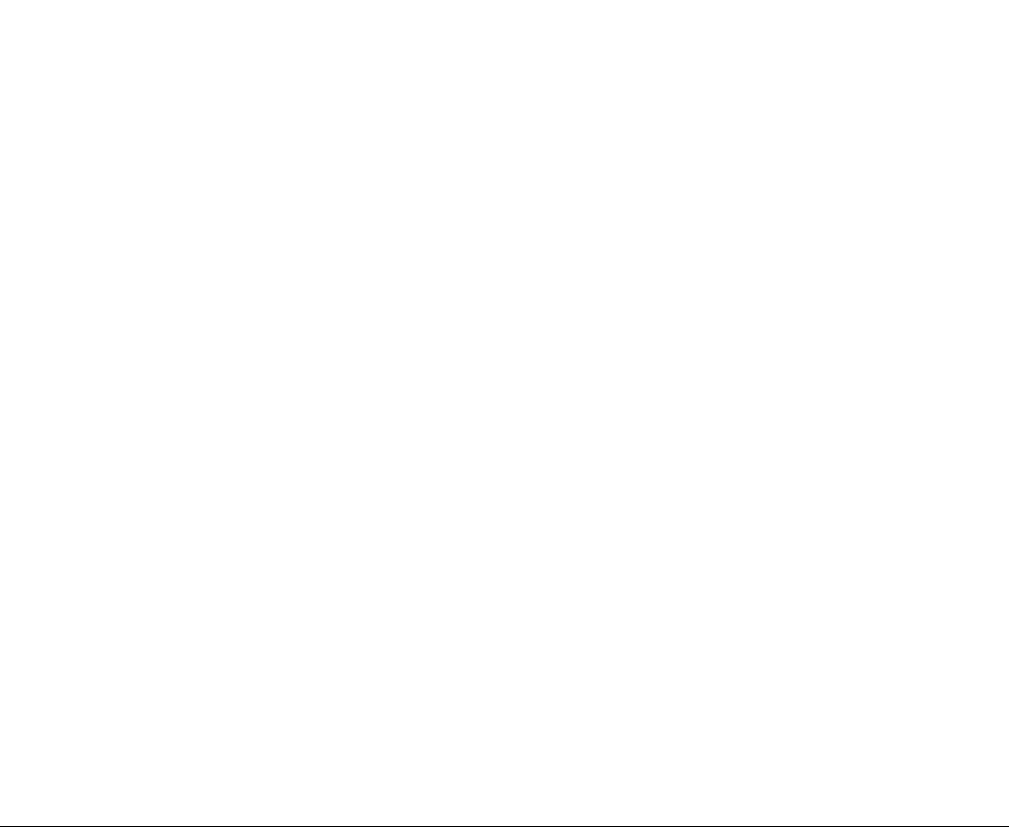
FIGUREA3 | Spatial distribution of deoxy-hemoglobin waveform 1. Colors within channels indicate normalized weights for this waveform according to the color bar. (A) LRC Group.The waveform has greater frontal weight in the neutral condition, and is distributed between focal frontal and